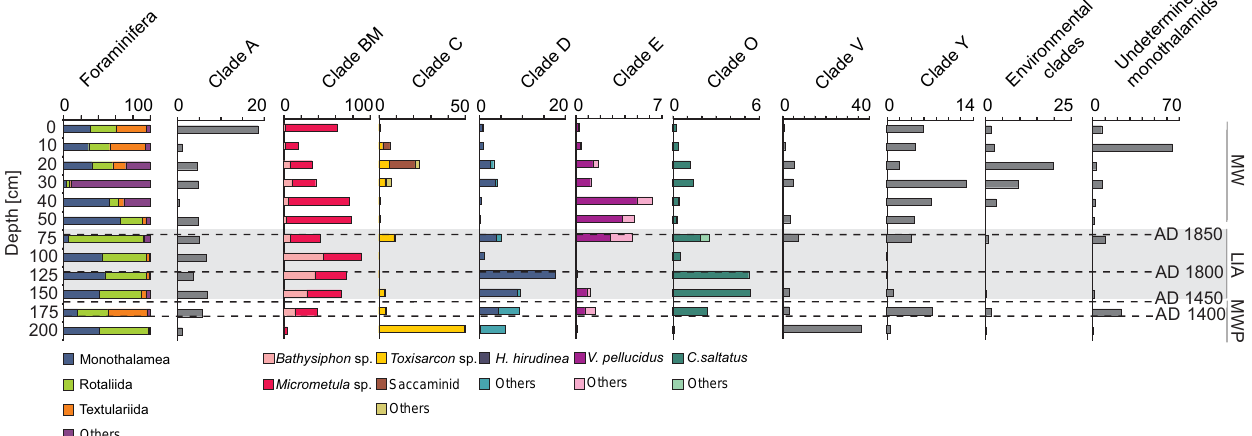
Figure 6. The relative abundance of the monothalamid sequences, expressed as the percentage of all foraminiferal sequences, and the com- position of the monothalamid assemblage, expressed as percentages of sequences within clades. Clades that constitute more than 5% of the monothalamid sequences in at least one sample are presented. “Environmental clades” relate to foraminifera known only from environmental sequencing. The time ranges of the MWP, LIA and MW are presented after Majewski et al.